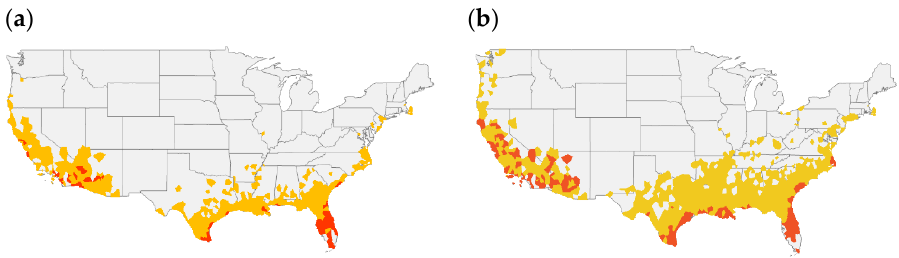
Figure 2. Thirty-year U.S. temperature below 10th percentile during months of November and December. ( a ) 32 ◦ F 10th percentile and ( b ) 28 ◦ F 10th percentile. Red color represents the areas that have less than a 10% chance of freeze during the month of December, and the combination of red and orange colors represents the data for the month of November (note: 32 ◦ F = 0 ◦ C, 28 ◦ F = − 2.2 ◦ C).